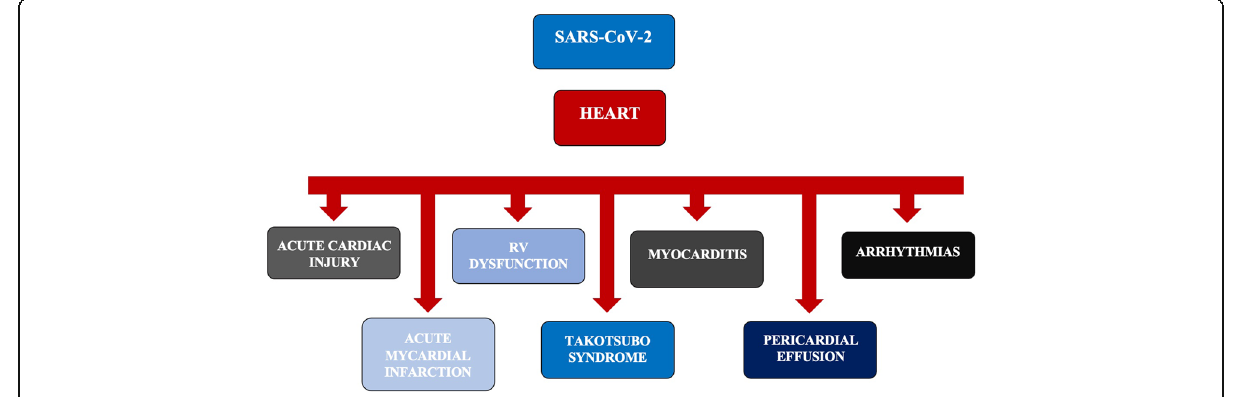
Fig. 1 Graphical representation of cardiac complications in SARS- CoV-2 patients